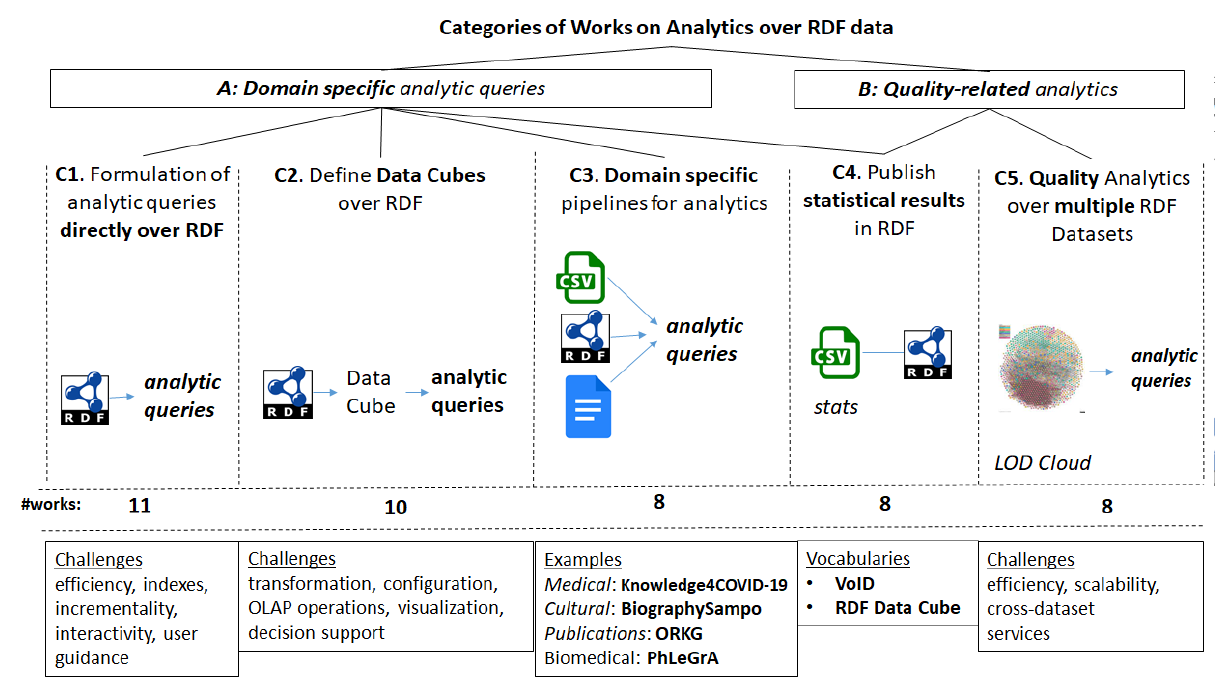
Figure 10. Summary of the surveyed